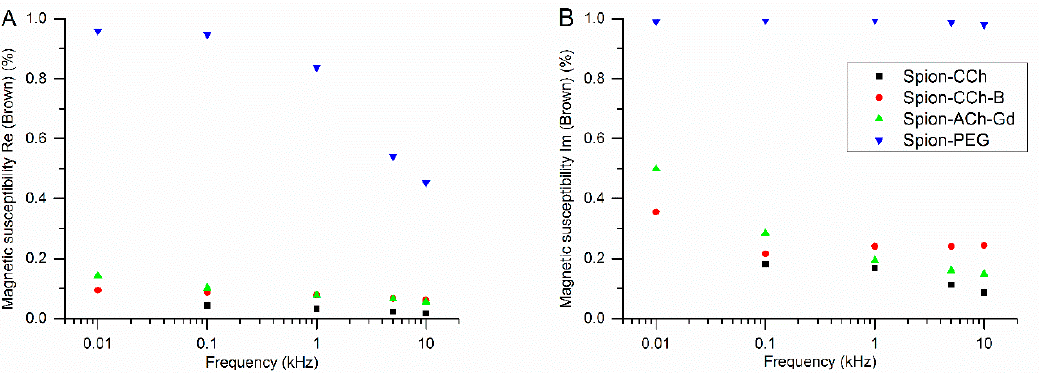
Figure 7. Relative contribution of Brown’s relaxation in ( A ) the dispersion part and ( B ) absorption part of the magnetic susceptibility at freezing temperature as a function of the excitation frequency.